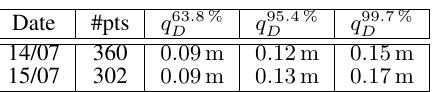
Table 4. Statistical values for the differences at the calibration track (quantiles of the horizontal